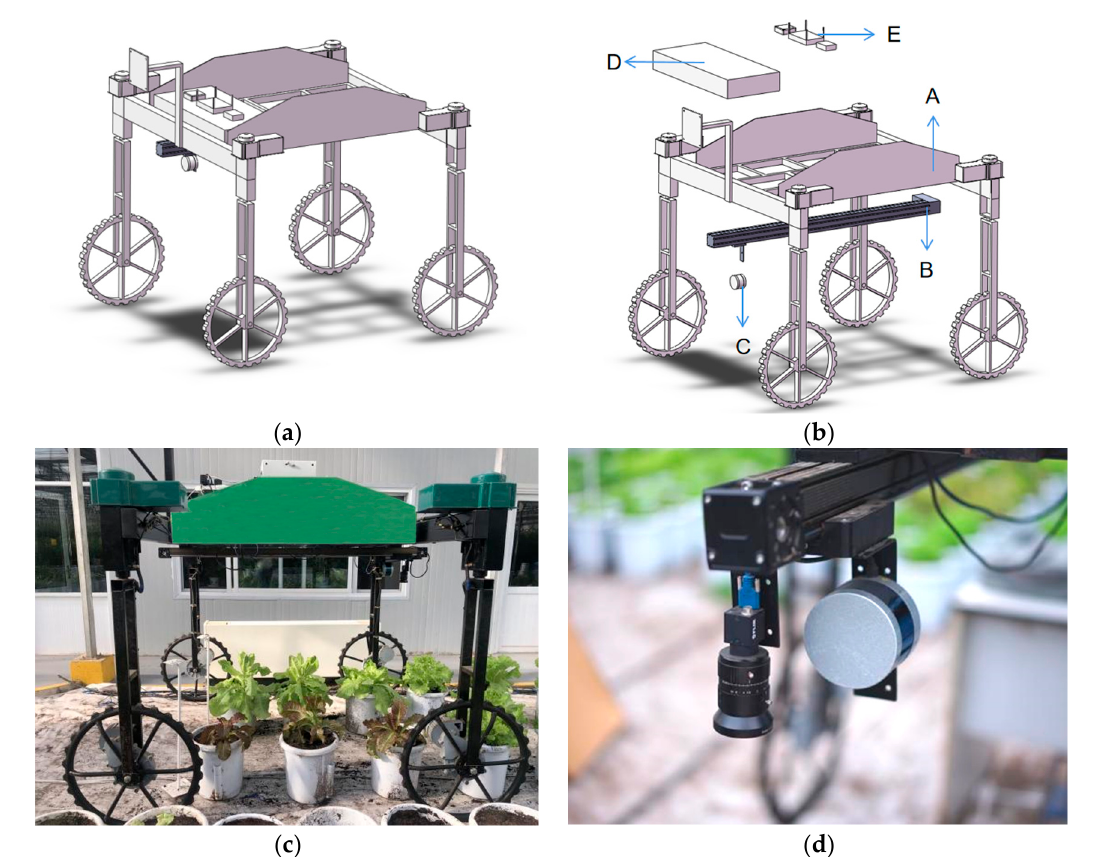
Figure 2. Hardware structure and physical structure of the UGV. ( a ) Three-dimensional view; ( b ) Three-dimensional decomposition diagram; ( c ) real view of the UGV collecting data; ( d ) LiDAR installation diagram.